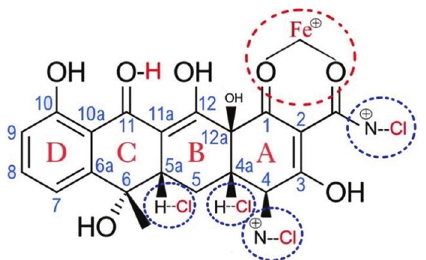
Figure-3: The ring structure of tetracycline dissolved in 0.1 N HCl and added with 1% Fe(III) Cl, and atom ferric bonded in the red ring, then Cl bonded in the blue